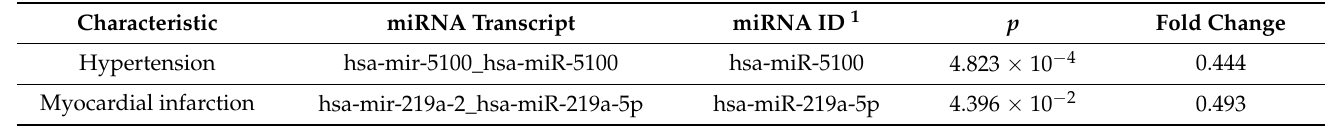
Table 5. Results of the differential expression analysis of 24 miRNAs selected as potentially associated with LEAD indicators, performed between subgroups of patients with different status of analyzed categorical characteristics. The table presents the miRNAs resulted from the DESeq2 analysis with Benjamini-Hochberg FDR <